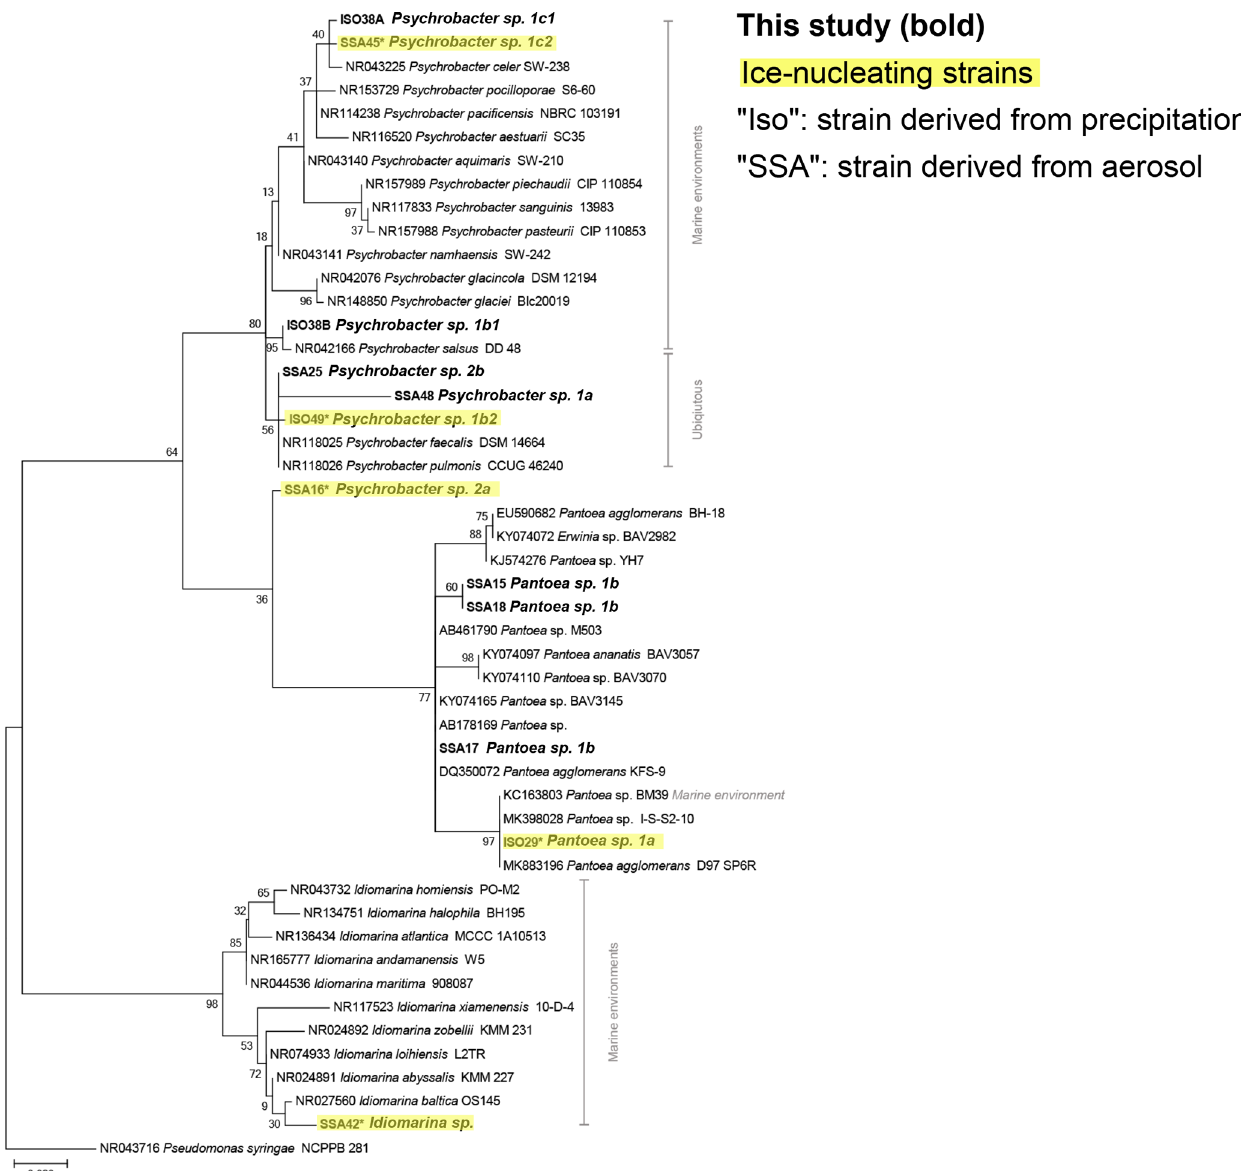
Figure 3. Maximum likelihood phylogenetic tree based on 420 nucleotides of the 16S rRNA gene sequences showing the phylogenetic relationships of isolates (in bold) related to Gammaproteobacteria reference sequences. The environmental source of the reference sequences (based on National Center for Biotechnology Information, NCBI, metadata) is indicated in gray. Isolates with ice-nucleating properties are shaded in yellow; bootstrap values ( n = 500) are indicated at nodes; the scale bar represents changes per